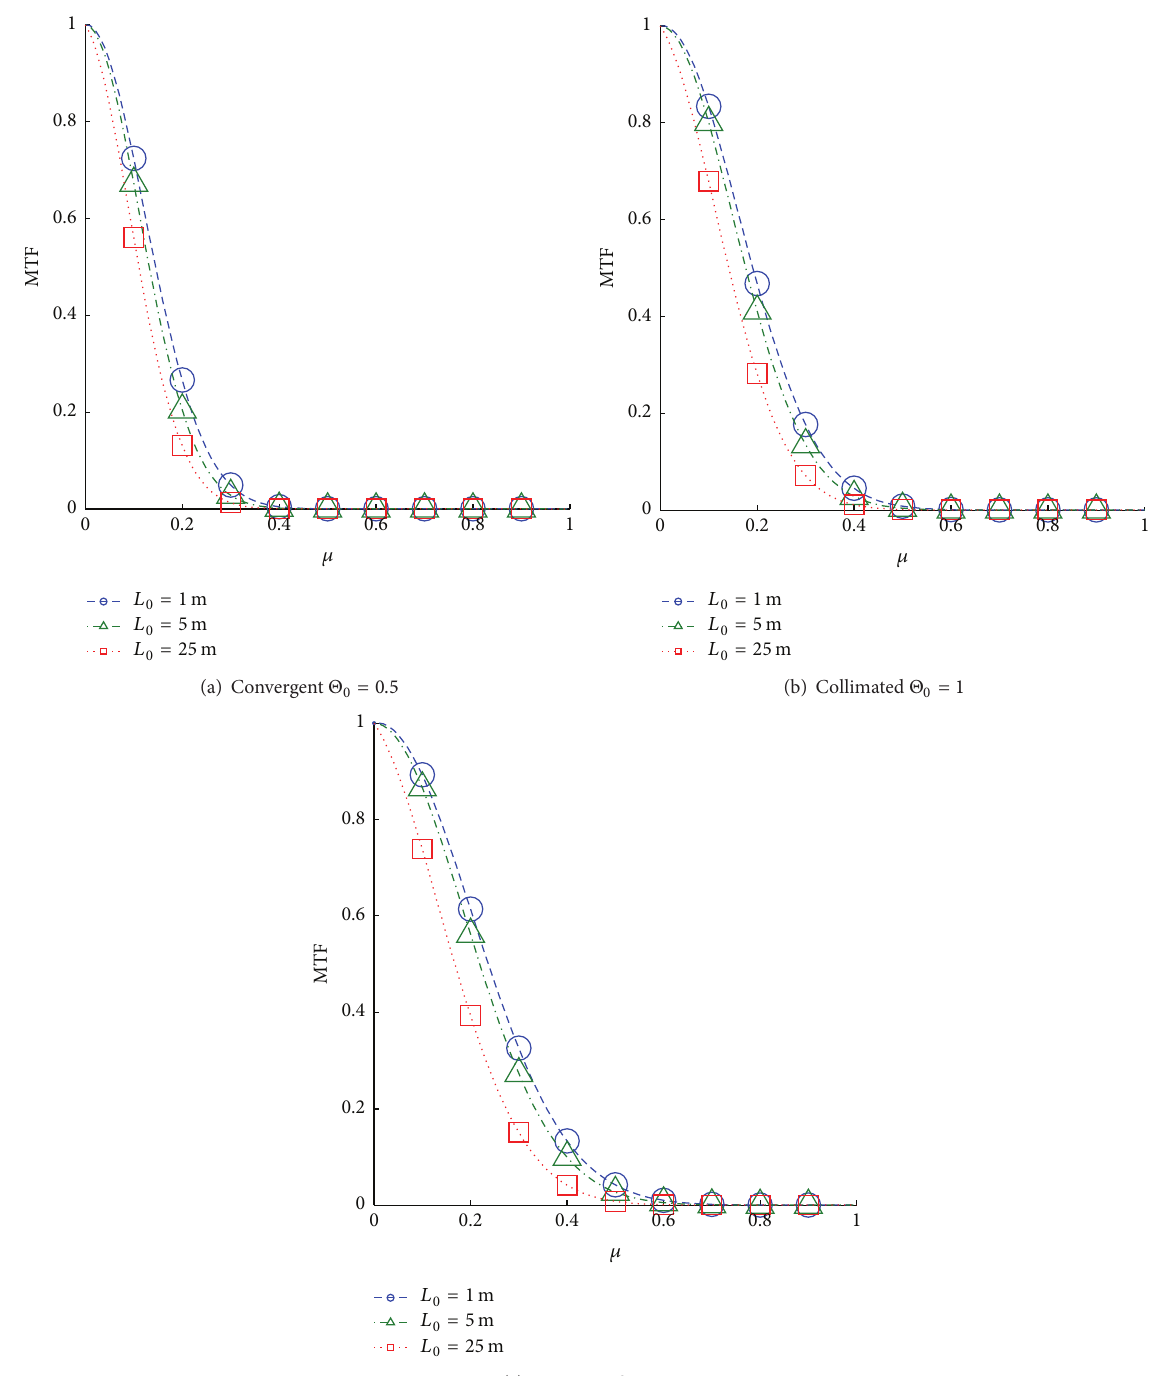
Figure 3: Effects of outer scale on MTF for different types of Gaussian